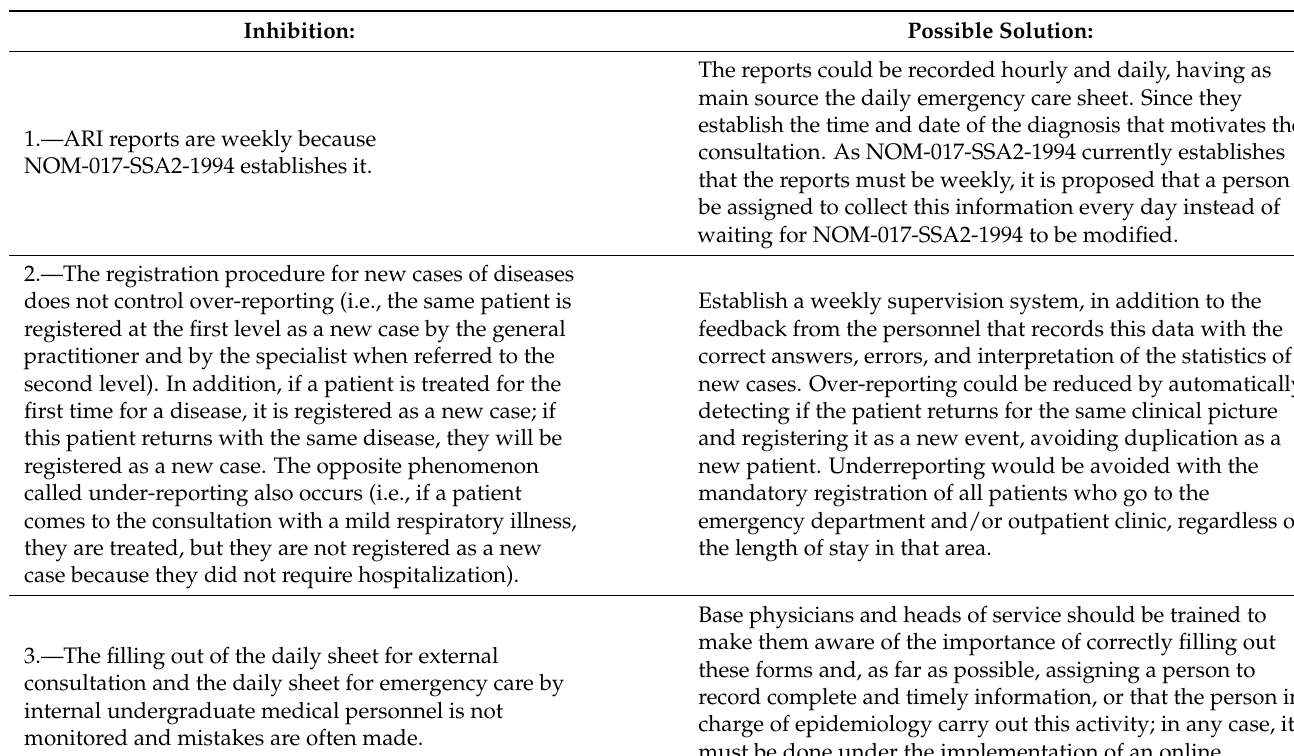
Table 2. Inhibitions and solutions for the daily recording of morbidity data for ARIs in Mexicali B.C.